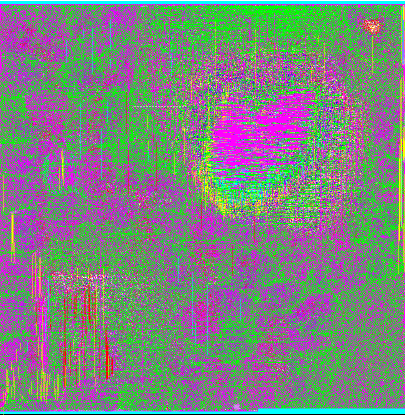
Figure 11. 5G NR QC-LDPC encoder